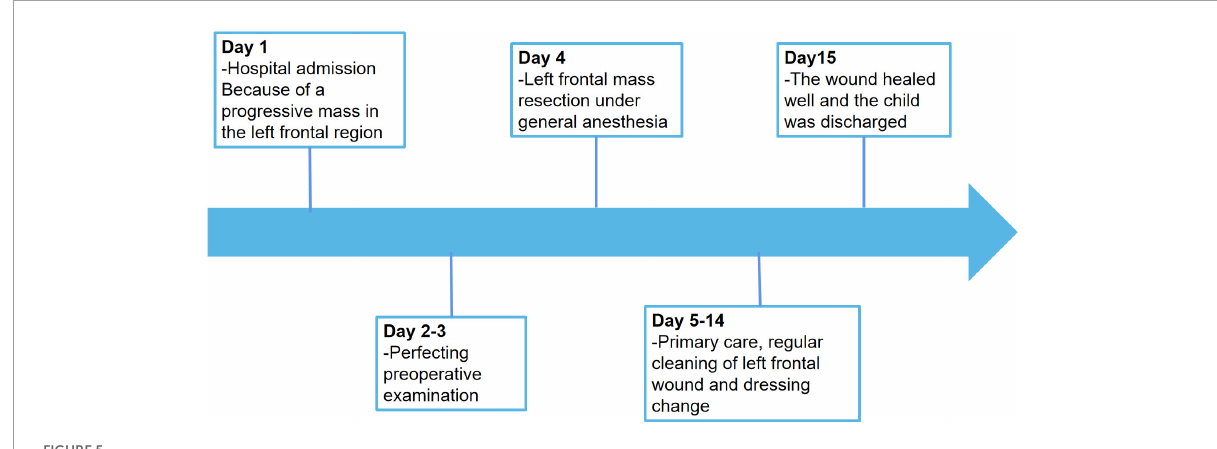
FIGURE5 Timeline of the patient’s clinical